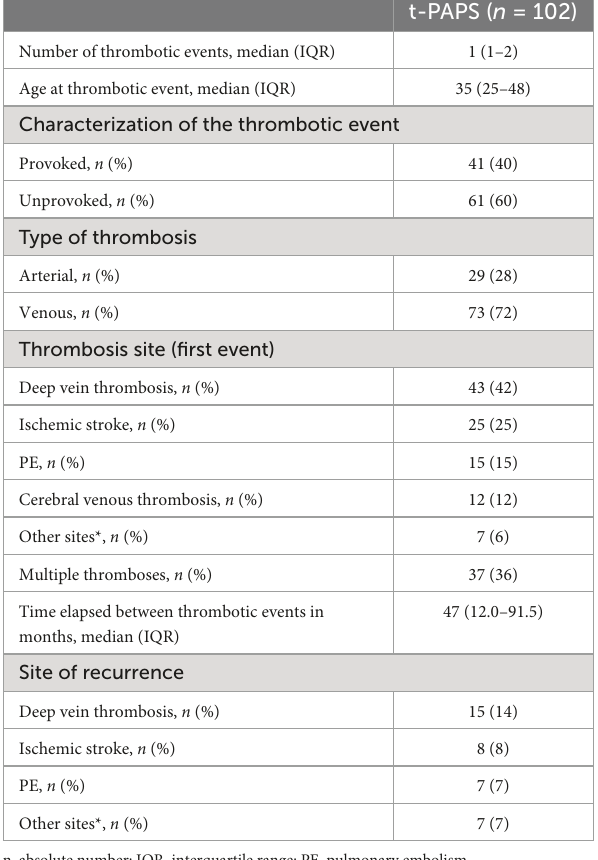
TABLE 1 Demographic, clinical and laboratory features of the study participants.